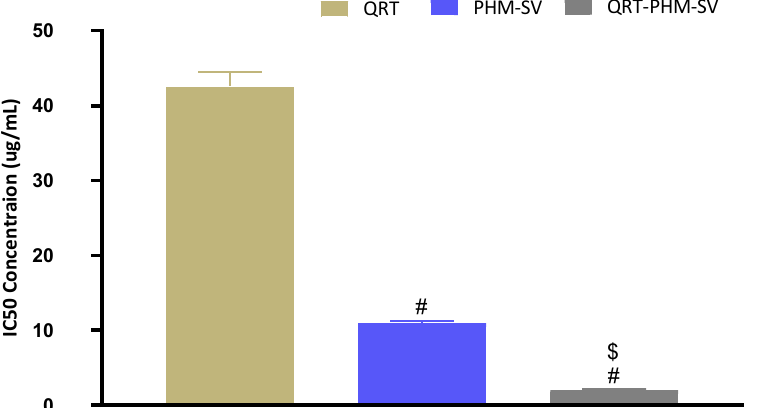
Figure 6. Representation of the IC 50 values of QRT, PHM-SV, and QRT-PHM-SV in MCF-7 cells. # Significantly different from QRT at p < 0.05. $ Significantly different from PHM-SV at p < 0.05.